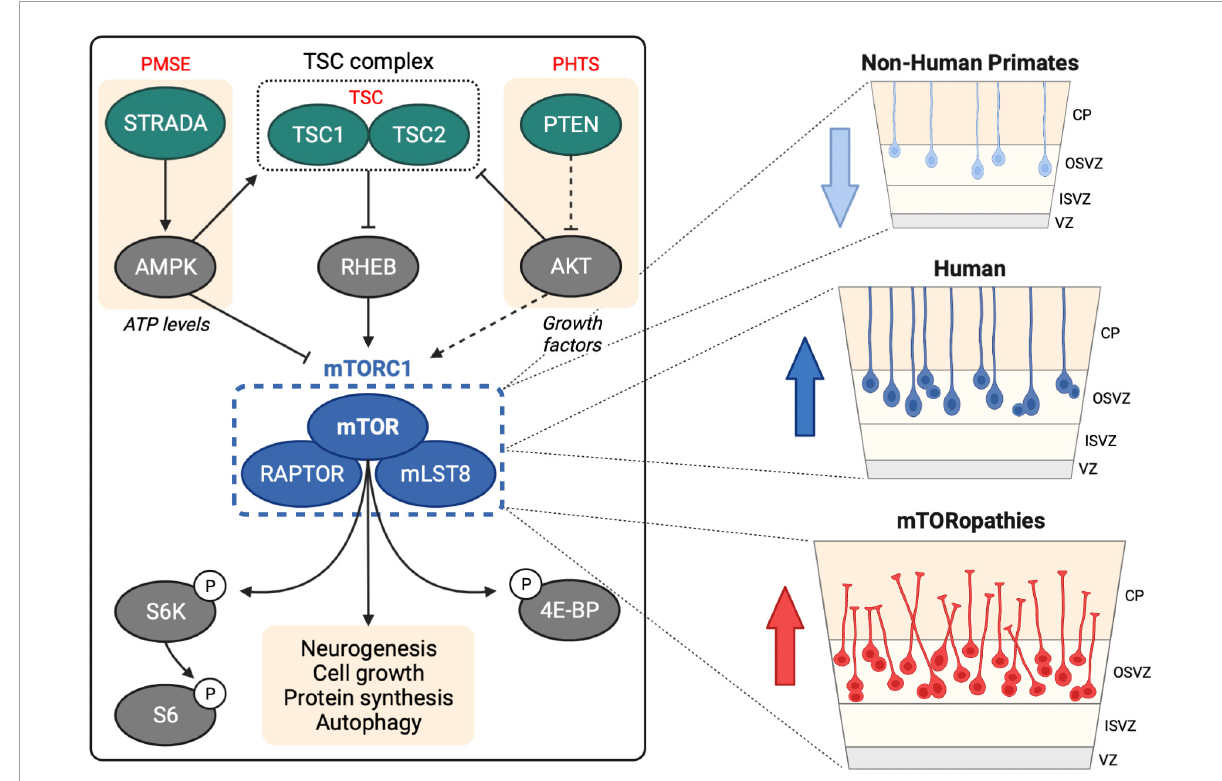
FIGURE1 mTOR signaling in human neurogenesis. Left hand panel shows upstream regulation of mTORC1 by the TSC complex, STRADA and PTEN, mutations in which cause TSC, PMSE and PHTS, respectively. mTORC1 regulates several downstream processes through direct and indirect targets including S6 kinase (S6K), ribosomal protein S6 (S6) and eukaryotic translation initiation factor 4E (eIF4E)-binding protein (4E-BP). Right hand panel shows oRG cells in the human OSVZ, which are less prevalent in non-human primates. Activation of mTOR signaling in oRG may contribute to MCD in